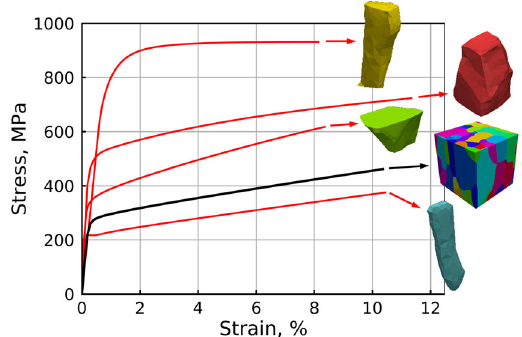
Fig. 2 Homogenized RVE vs. individual grain stress – strain. Comparison of homogenized RVE stress – strain behavior (black line) compared to individual grain behaviors from the same RVE (red lines) demonstrating how extreme gain behaviors can be masked through